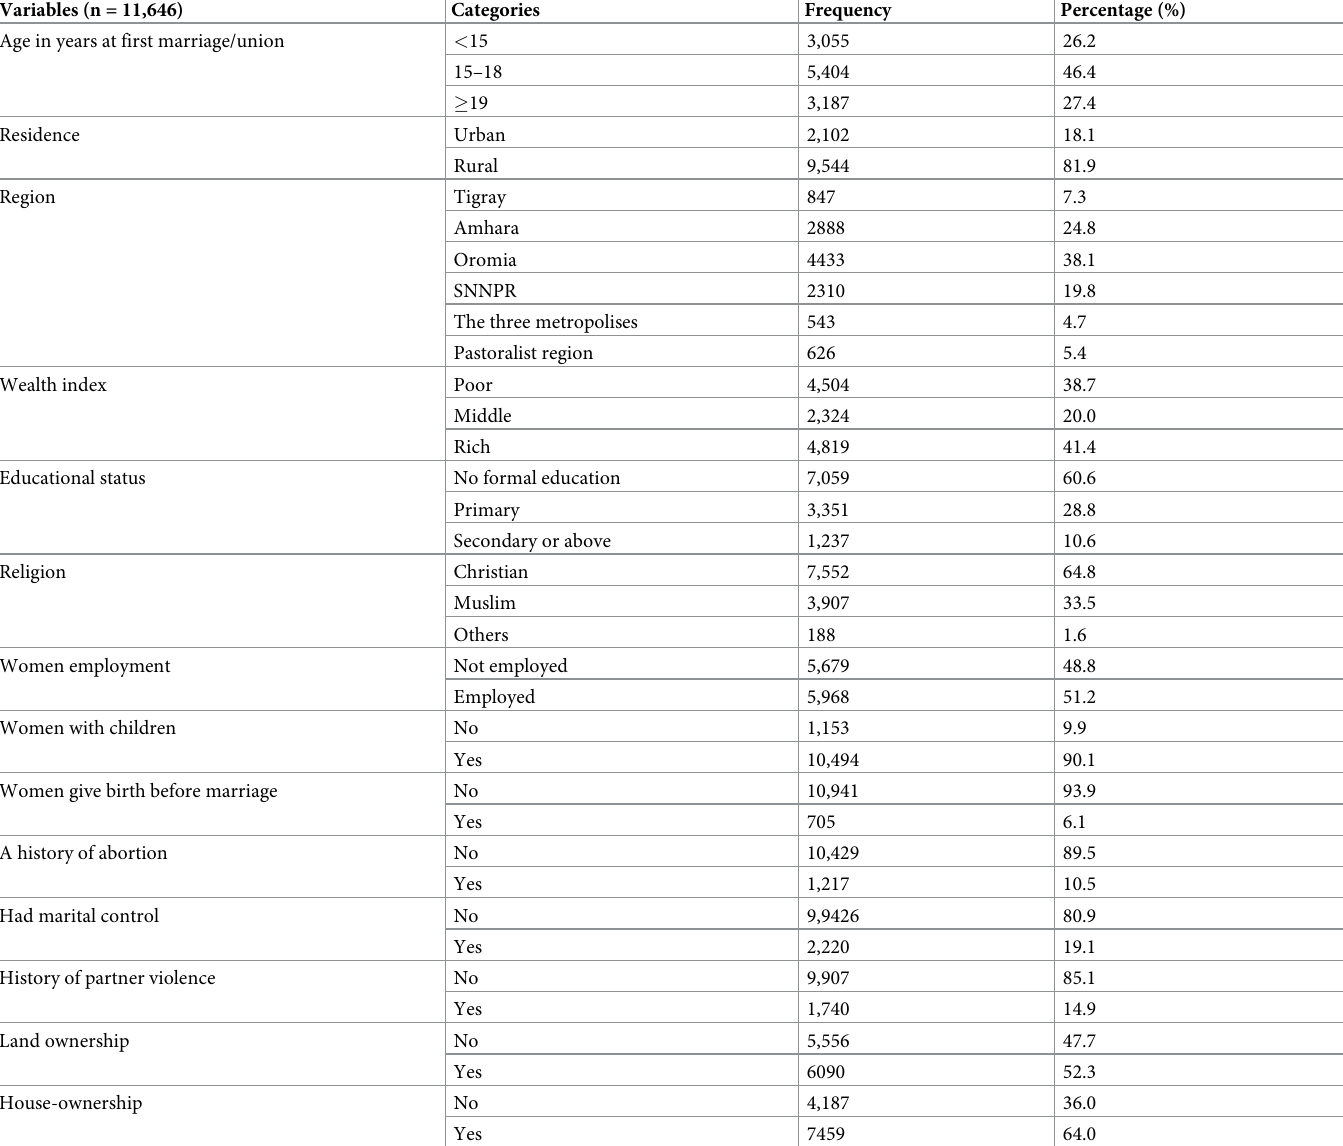
Table 1. Sociodemographic characteristics of ever-married women in Ethiopia, 2016 EDHS. Variables (n =